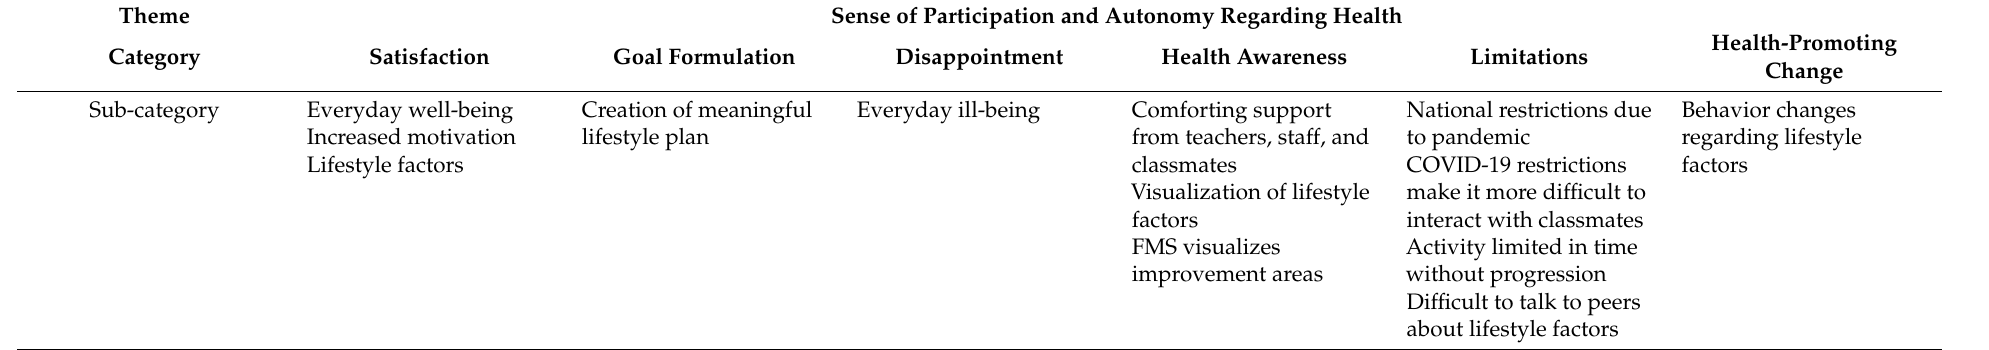
Table 2. Sub-categories, categories, and themes abstracted from the meaning-bearing